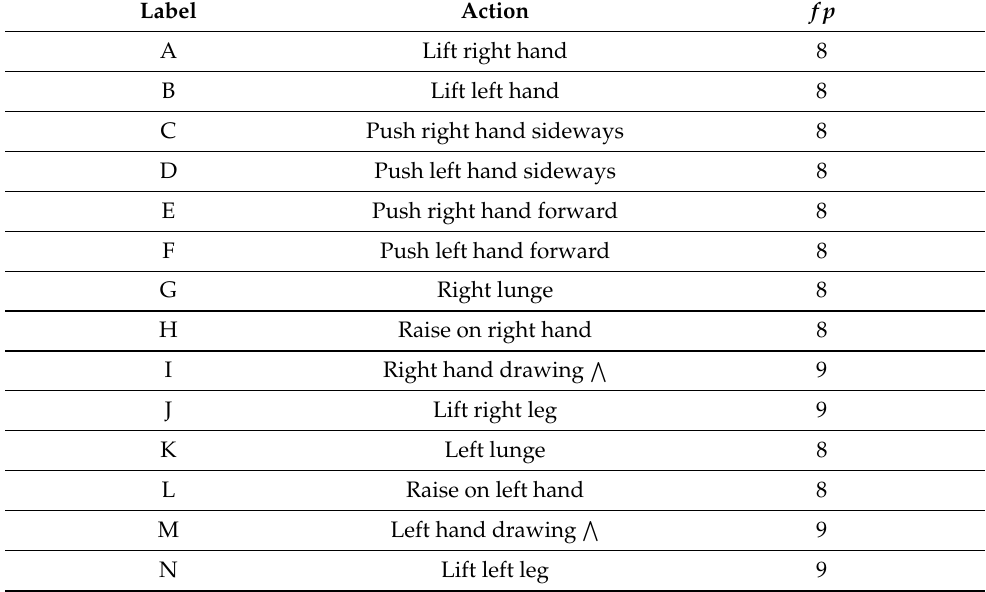
Table 3. Parameter f p of